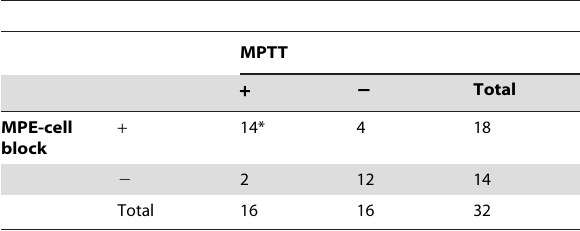
Table 3. Comparison of EGFR mutation between MPE-cell blocks and matched MPTTs.